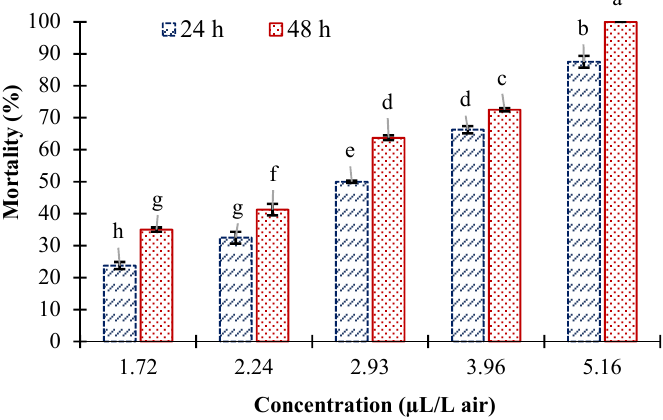
Figure 2. Mean mortality percentage ( ± SE) of C. maculatus adults exposed to fumigation with Eucalyptus largiflorens essential oil. Different letters indicate statistically significant differences accord- ing to Tukey’s test at p ≤